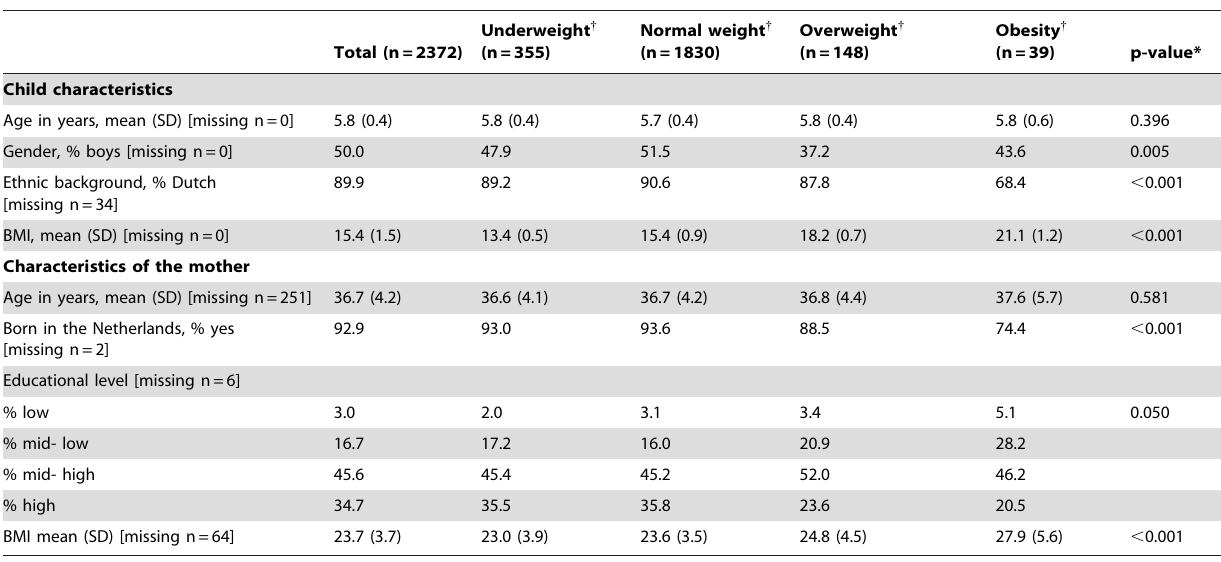
Table 2. General characteristics of the study population, stratified by children’s weight status (n=2372).